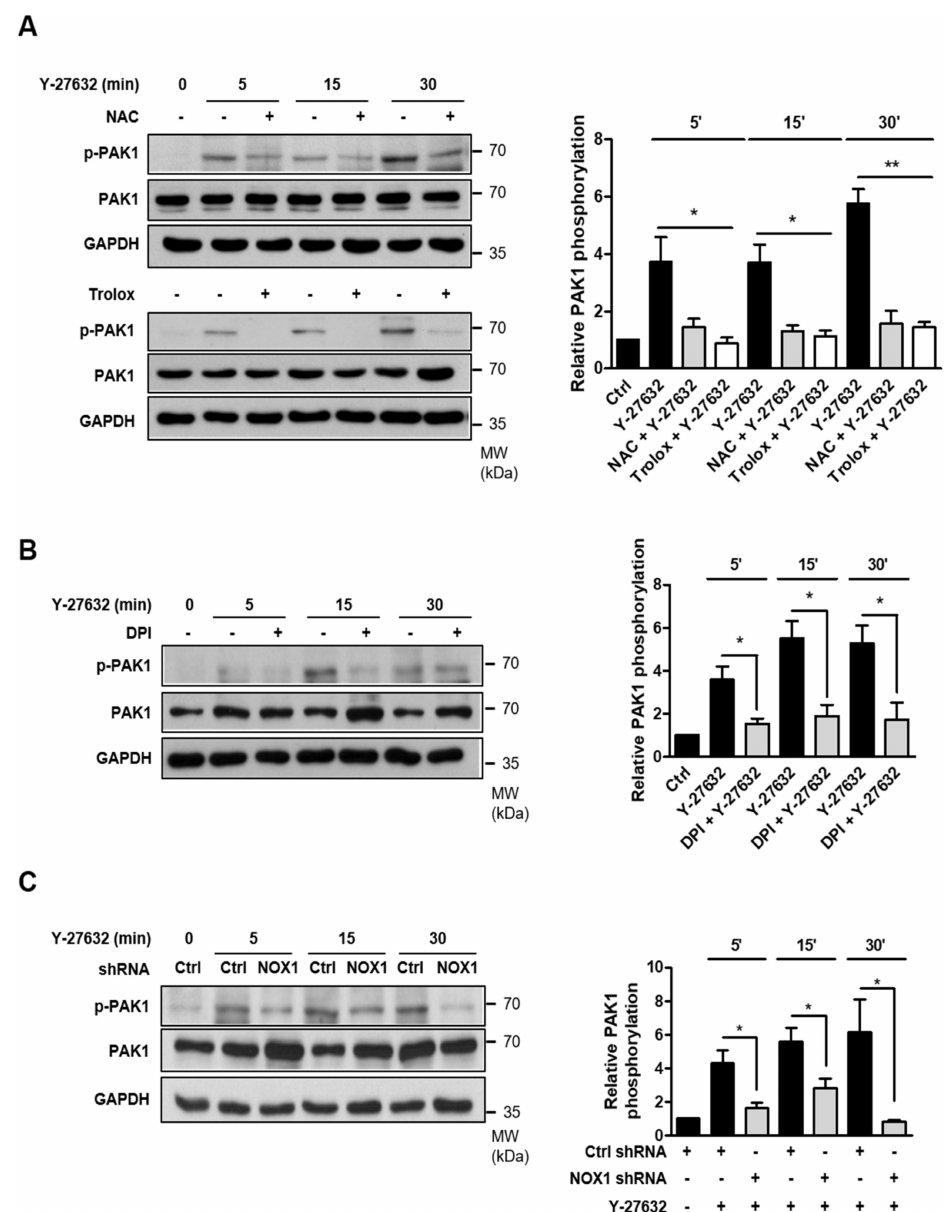
Figure 4. NOX1-mediated ROS generation is required for Y-27632-induced PAK1 activation. ( A ) PC12 cells were treated with 25 µ M Y-27632 for the indicated times in the presence or absence of ROS scavengers, such as 5 mM NAC and 500 µ M trolox, and cell lysates were then immunoblotted with antibodies against phosphorylated PAK1 (at Ser199 / 204), PAK1, and GAPDH. The p-PAK1 protein expression level was normalized to that of total PAK1 and is shown in the right panel. ( B ) PC12 cells were treated with 25 µ M Y-27632 for the indicated times in the presence or absence of 10 µ M DPI, and the cell lysates were then immunoblotted with antibodies against phosphorylated PAK1 (at Ser199 / 204), PAK1, and GAPDH. The p-PAK1 protein expression level was normalized against PAK1 and is shown in the right panel. ( C ) PC12 cells transfected with control shRNA or NOX1 shRNA were treated with 25 µ M Y-27632, and the cell lysates were then immunoblotted with antibodies against phosphorylated PAK1 (at Ser199 / 204), PAK1, and GAPDH. The p-PAK1 protein expression level was normalized to that of total PAK1 and is shown in the right panel. Note that scavenging ROS with NAC or trolox, inhibiting NOX1 with DPI, and knocking down NOX1 all inhibited Y-27632-induced PAK1 phosphorylation. The data represent the means ± S.E.M. of at least three independent experiments. * p < 0.05; ** p <